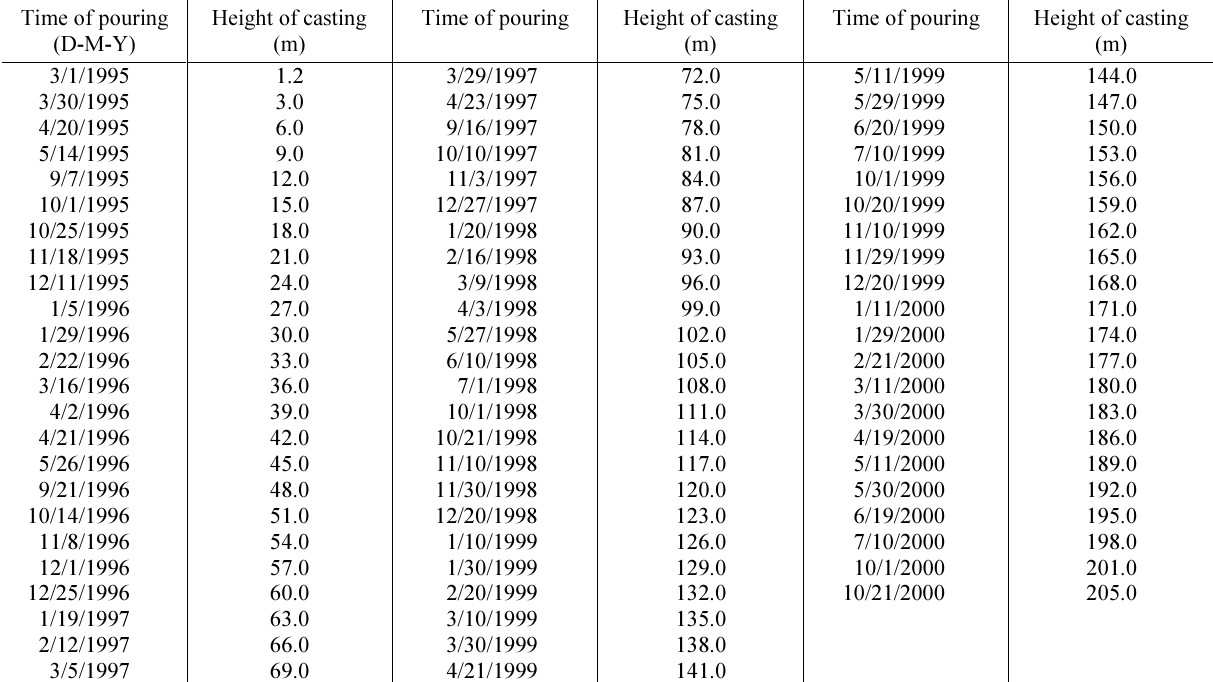
Table 4. Construction schedule of Karun III RCC Arch